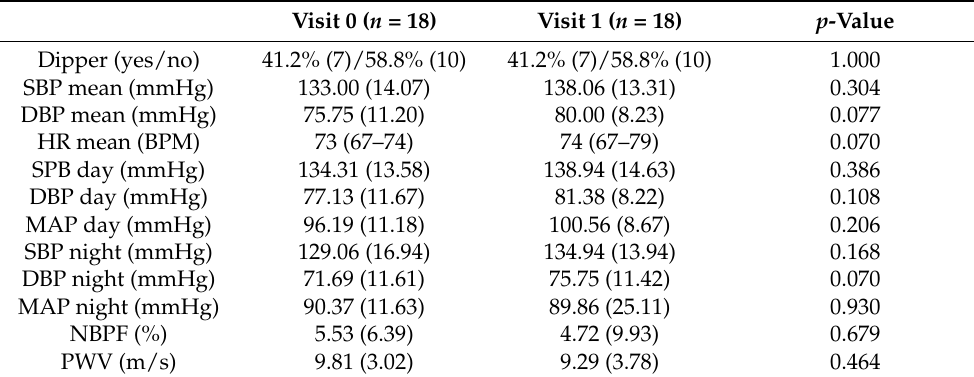
Table 3. Blood pressure and pulse wave velocity at the baseline visit and after a 3–month sodium administration in non–dialysed CKD 3–5 stages